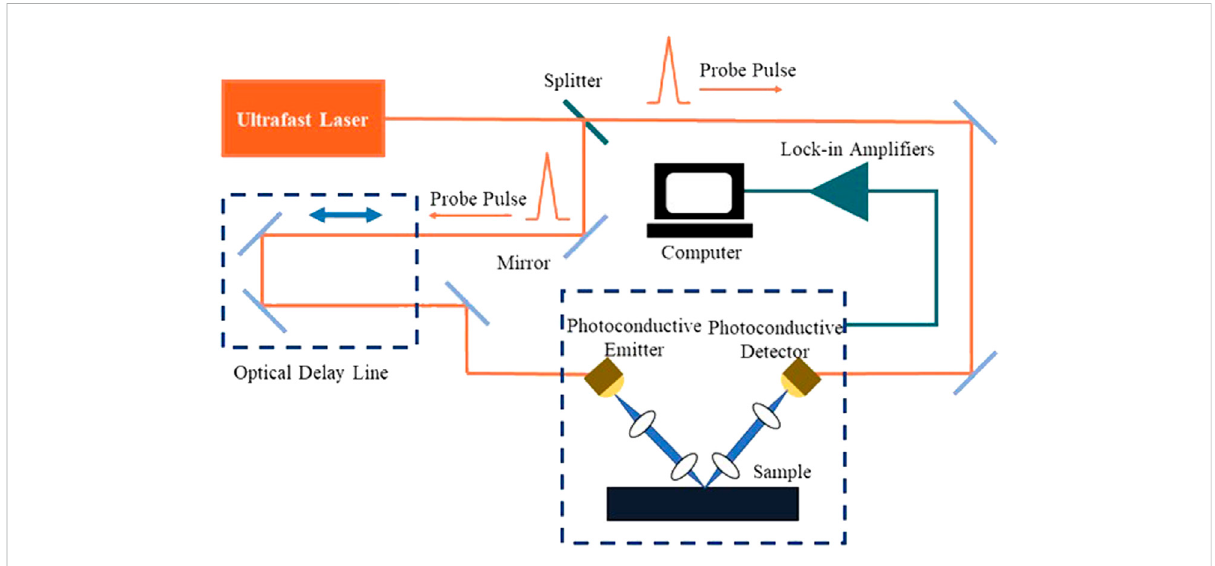
FIGURE 7 Schematic of a THz-TDS system setup for a composite